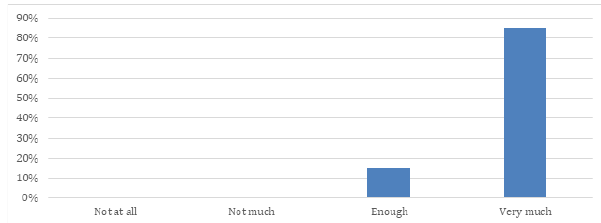
Figure 14. Evaluation graphic: are you satisfied of the virtual experience?